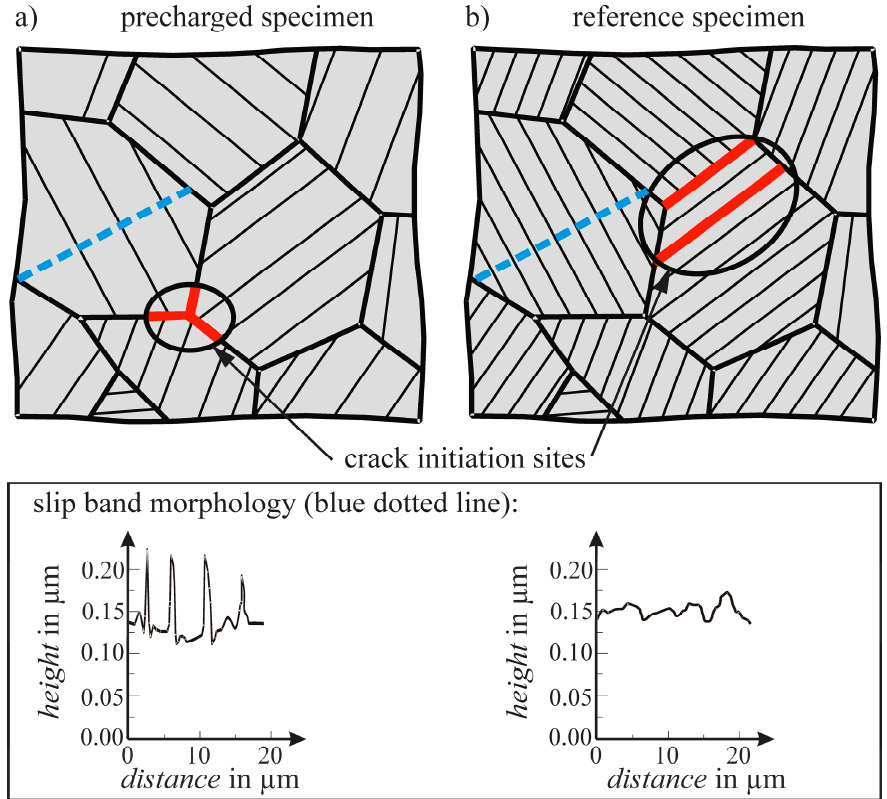
Figure 4. Schematic representation of crack initiation location and slip band morphology in ( a ) pre- charged and ( b ) reference specimen of X2-12 [4] (reproduced from [4], MDPI, 2018).